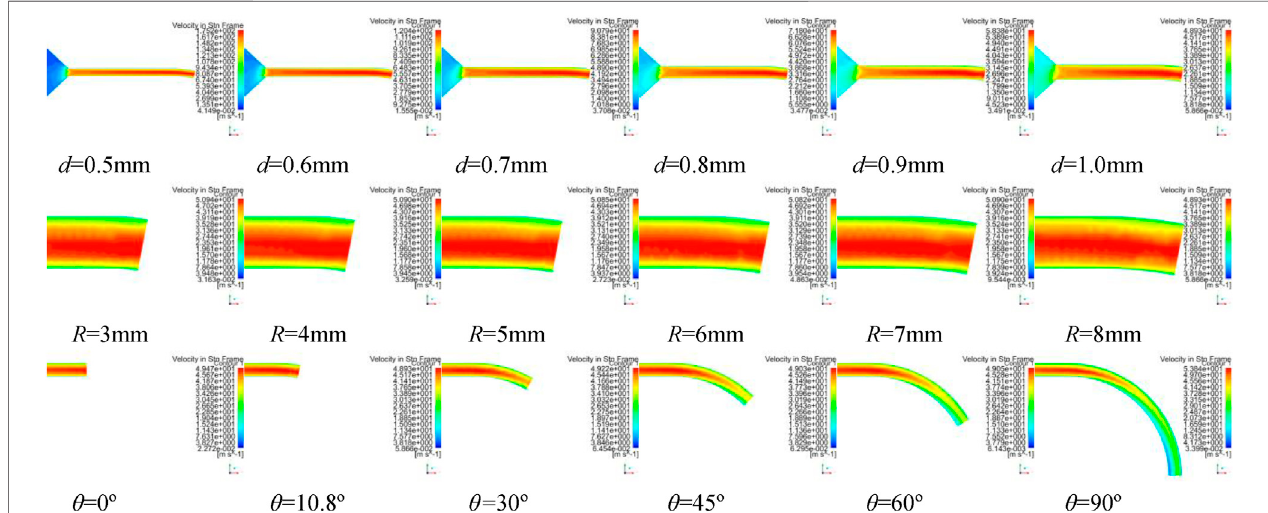
FIGURE 9 | The velocity contours of spinning solution in tube of curved-tube nozzle.